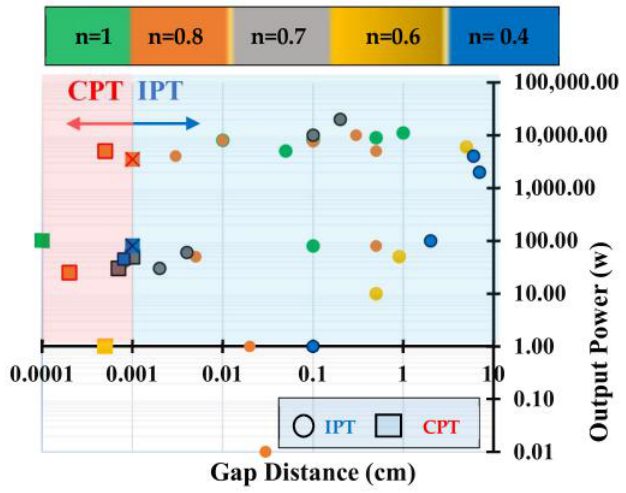
Figure 4. Graph of OUTPUT POWER (w) vs. GAP DISTANCE (cm).